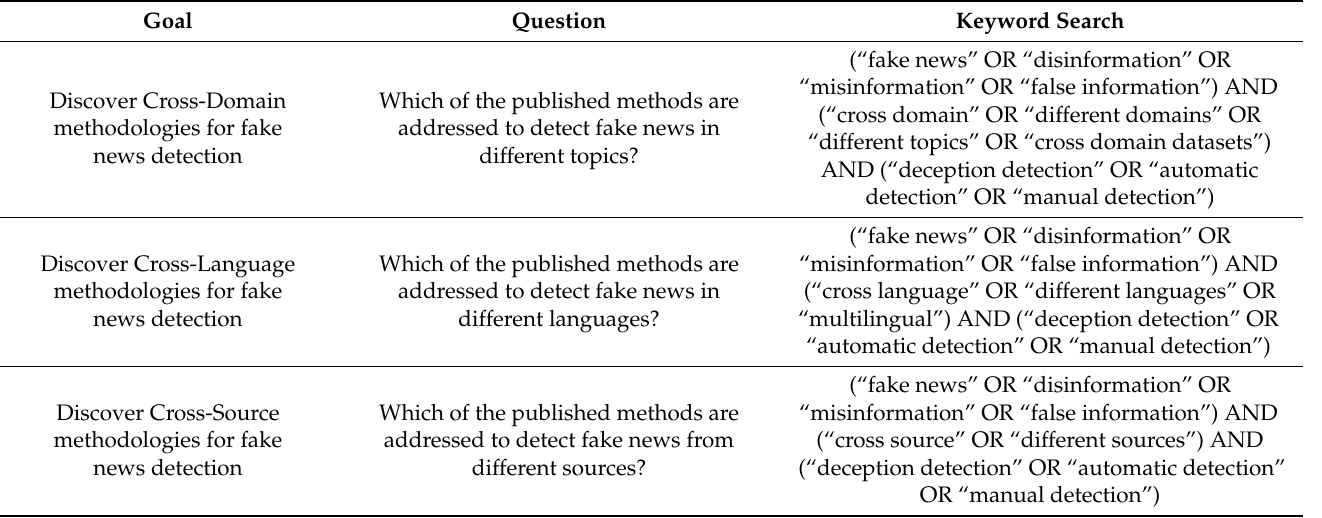
Table 1. Survey Methodology Attributes.